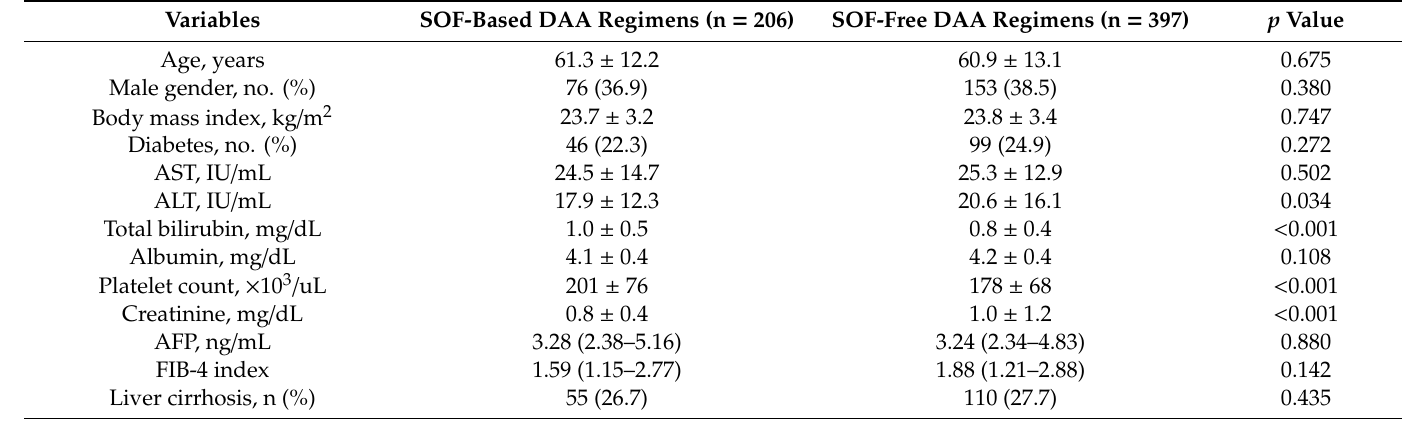
Table 4. Comparison of clinical characteristics between patients treated with SOF-based and SOF-free DAA